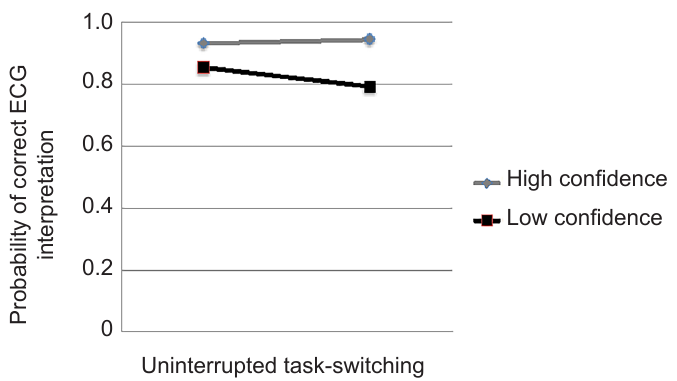
Figure 2. Interaction effect of confidence and scenario on the estimated probability of correct electrocardiogram (ECG) interpretation for ST-elevation myocardial infarction. Low confidence (black) refers to Likert scores of 1-3, whereas high confidence (gray) refers to Likert scores of 4-5. The p value for the interaction was